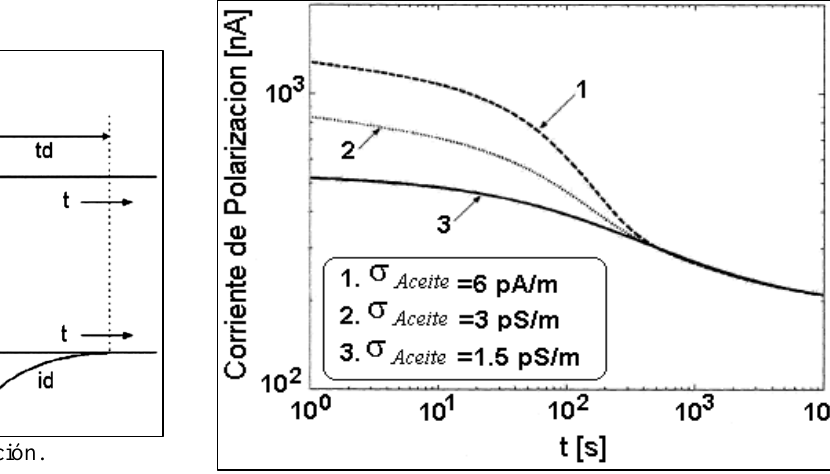
Figura 11: Variaciones de la corriente de polarización para varias conductividades del aceite. Fuente: Autores,